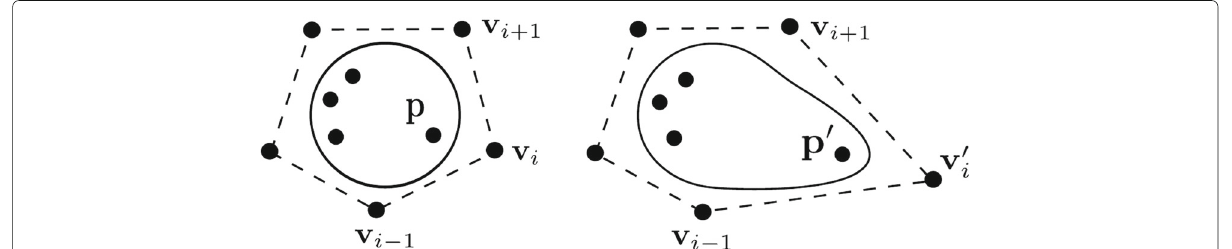
Fig. 1 Motion of a vertex. Influence of a vertex over the points on the plain (image from [18])